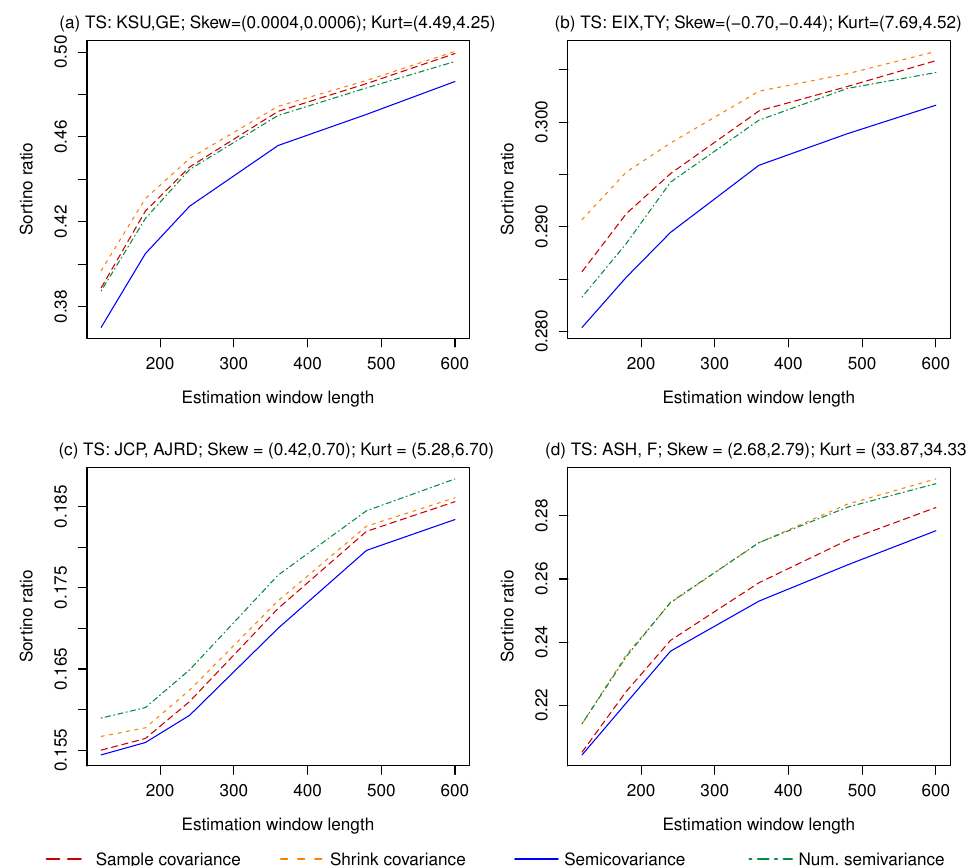
Figure 5. Sortino ratio achieved by mean-variance/semivariance portfolios constructed with assets with different idiosyncratic skewness. ( a ) Virtually zero skew; ( b ) Negative skew; ( c ) Positive skew; ( d ) Very positive